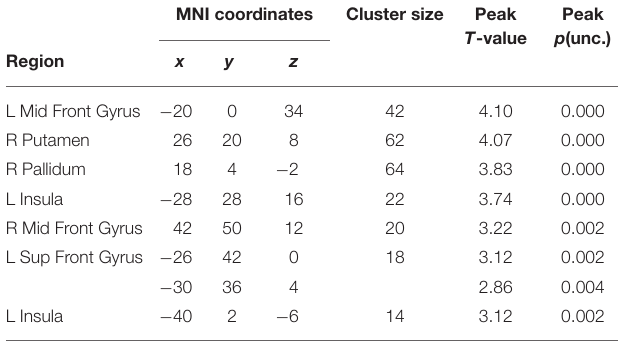
TABLE 1 | Brain activation of odor stimulation (contrast all six odors vs. baseline).